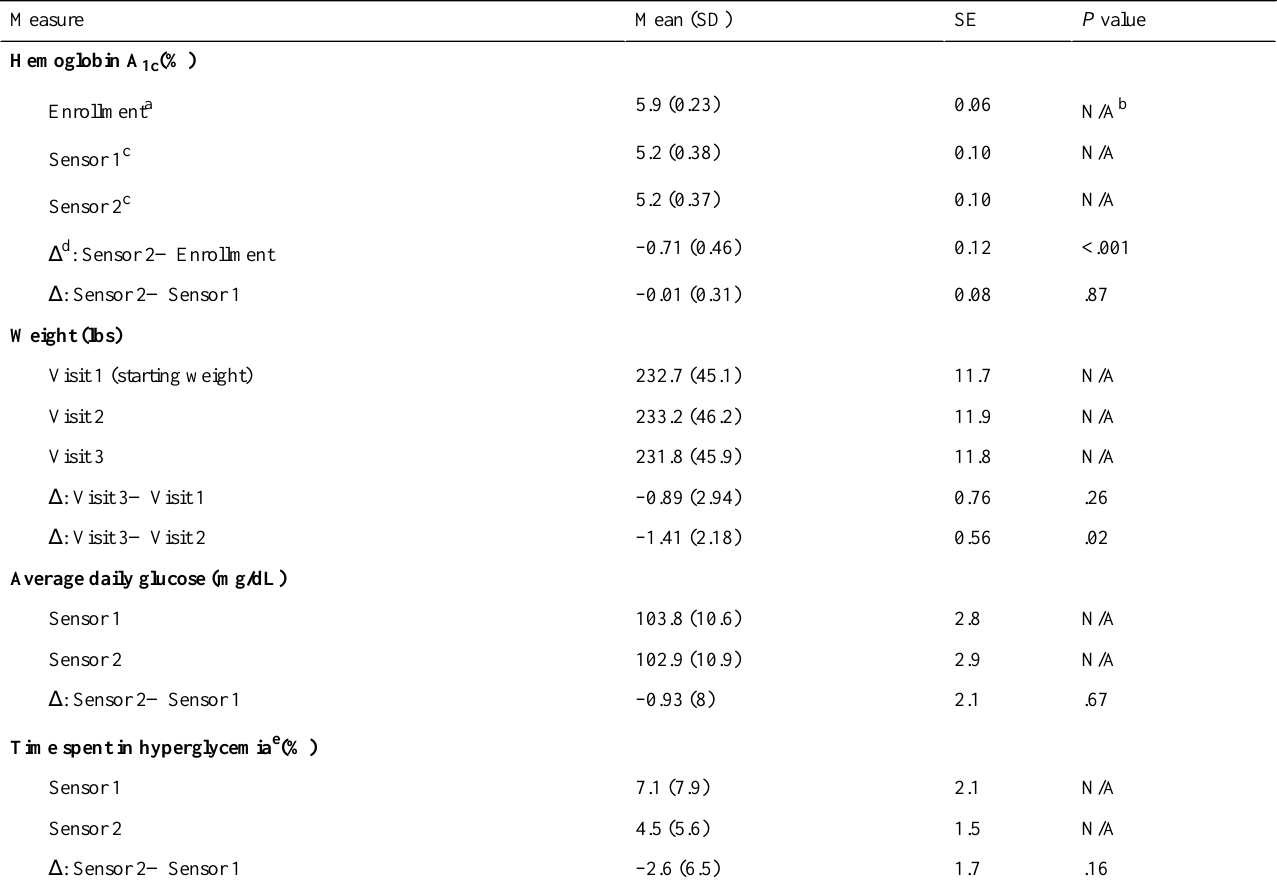
P valueSEMean (SD)Measure